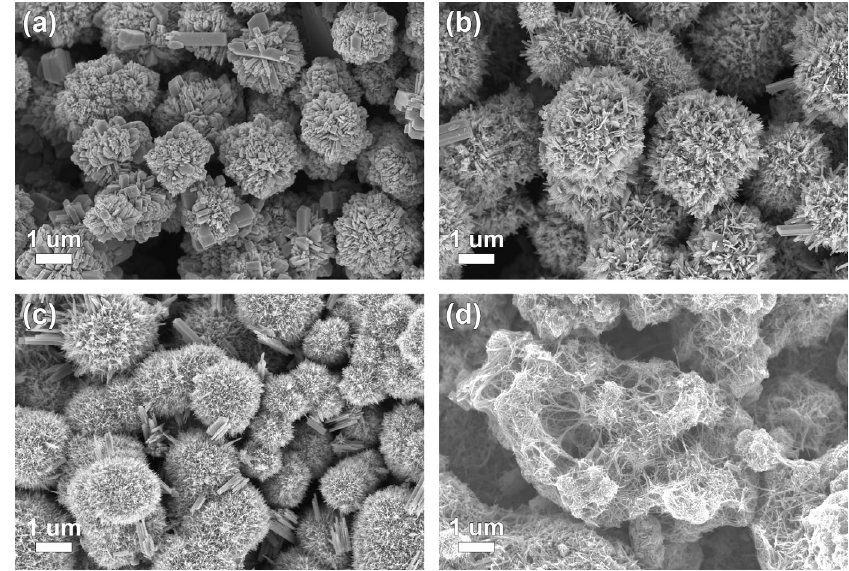
Fig. 2 SEM images of samples prepared in precursor with Tu concentration of 0, 0.05, 0.1, and 0.2